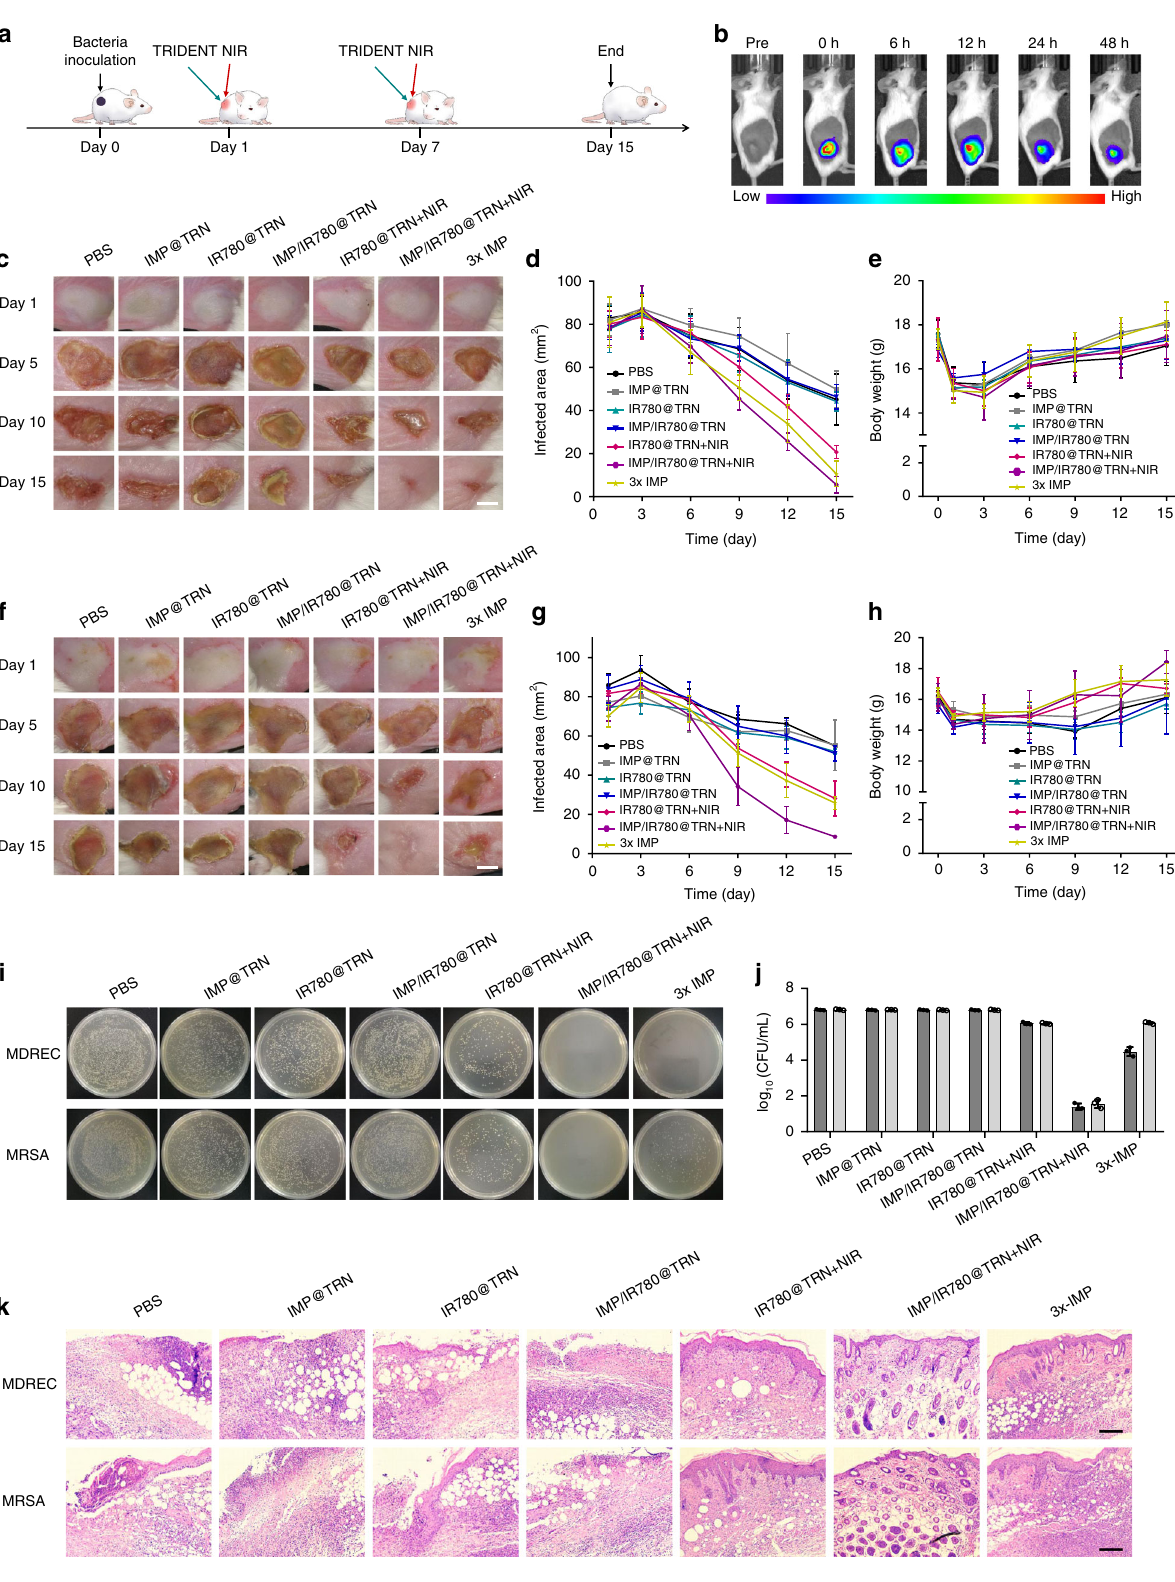
the best time. Secondly, NIR-irradiated IR780 molecules will generate a thermal response that not only melts the TRN but also damage the cell membrane via photothermal effect, which will assist with the third function for reducing the resistance to